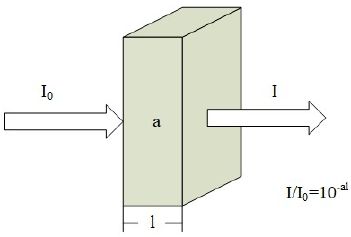
Figure 3. Schematic diagram of thr Lambert-Beer law .